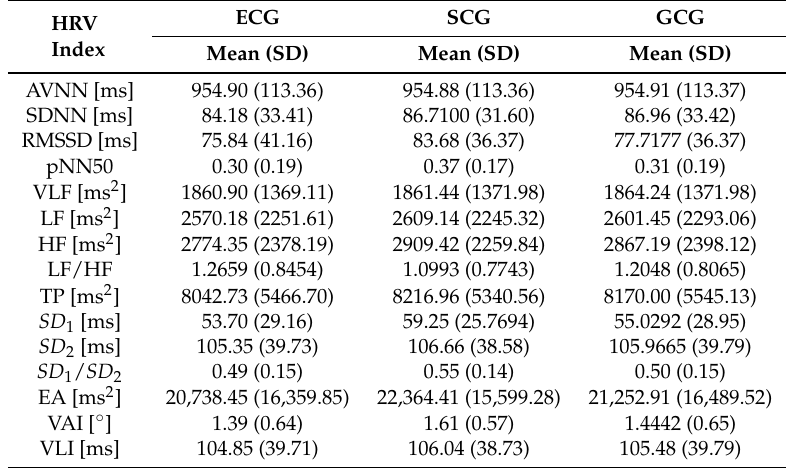
Table 2. Mean and standard deviation values of HRV indices calculated on full signals.